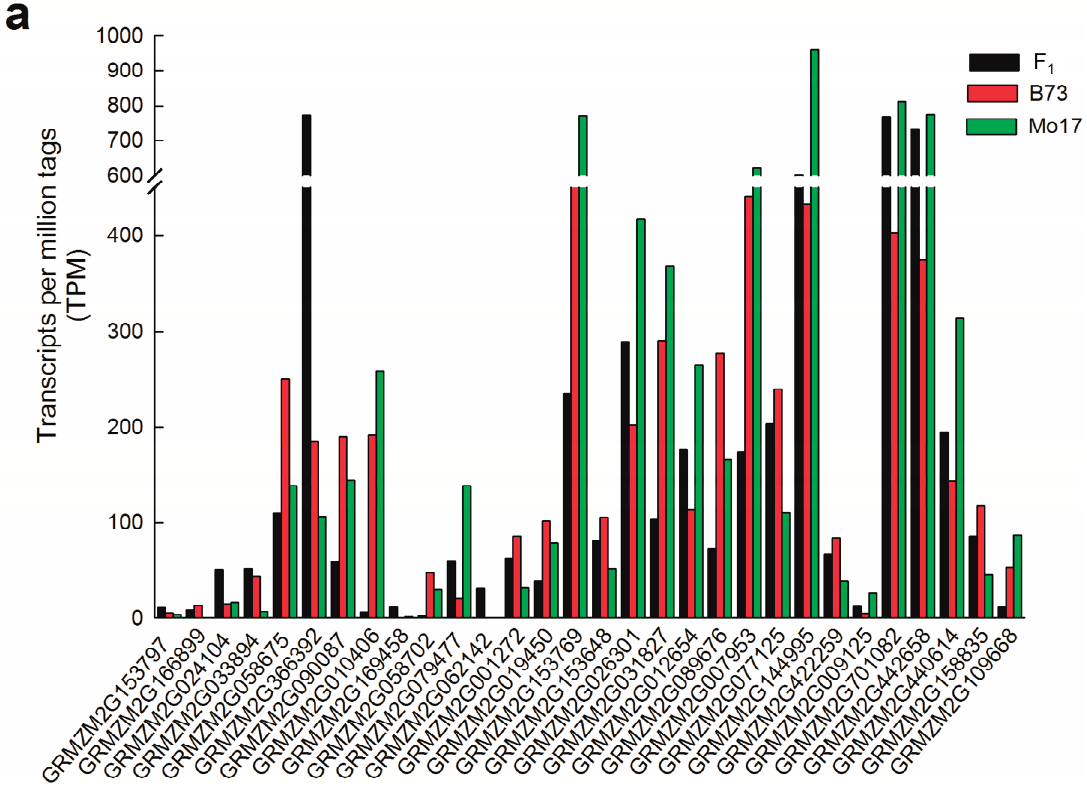
Figure 3. Expression of 12 differentially expressed gene from arginine and proline metabolism, pyruvate metabolism, and purine metabolism in the maize heterotic cross. The expression pattern of 12 genes detected by digital gene expression platform ( a ) and quantitative Real-Time PCR (qRT-PCR) ( b ). The black, red, and green bars in graph b depicted the stem-loop qRT-PCR relative expression level ± standard error of three replicates for each gene in B73, Mo17 and their